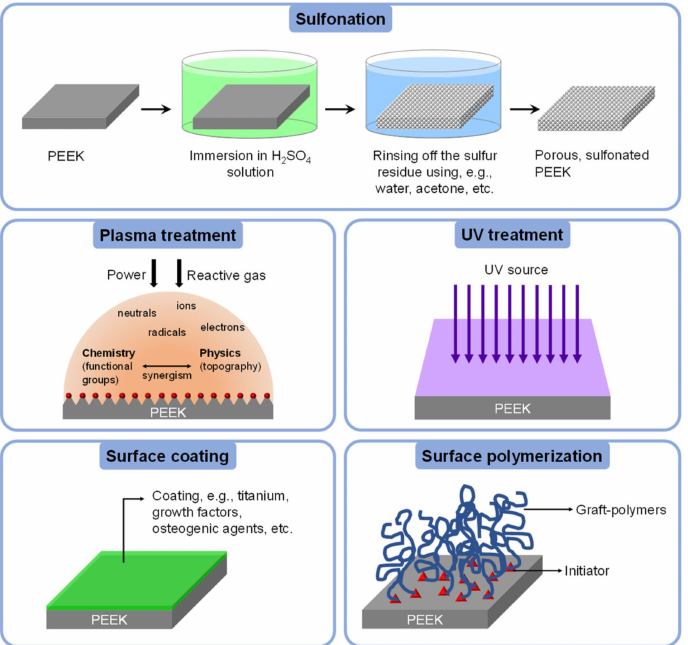
Figure 6. Illustration of chemical surface modifications of PEEK. The illustration is inspired by previously published literature